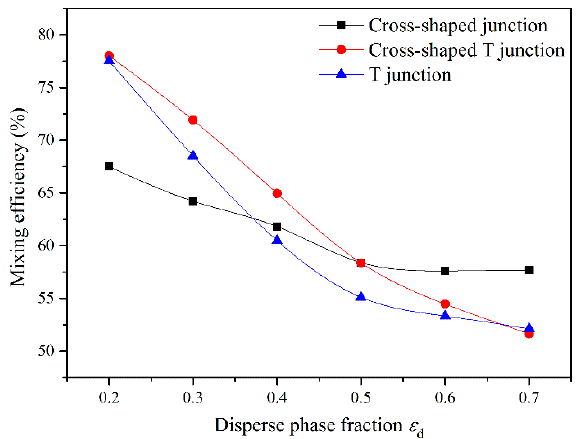
Figure 9. Mixing efficiency in different disperse phase fractions at the moment of droplet formation.